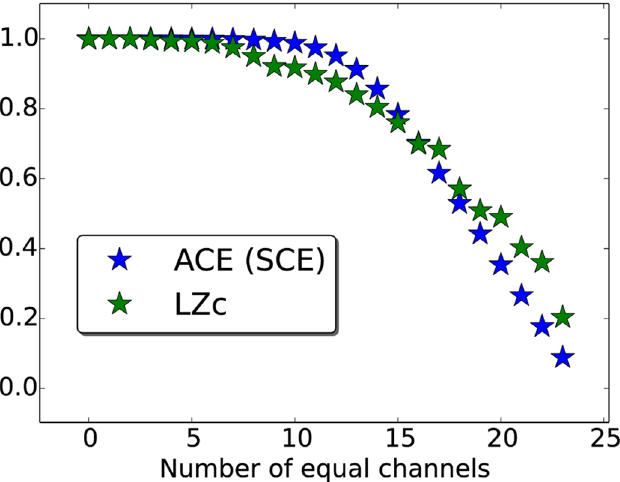
Fig 5. Complexity measures for increasingly regular activation/synchrony matrices. Given a random binary matrix of activations (for ACE and LZc) or synchronies (for SCE), with increasing number of duplicated channels, the complexity measures monotonically decrease with the number of equal channels. See text for